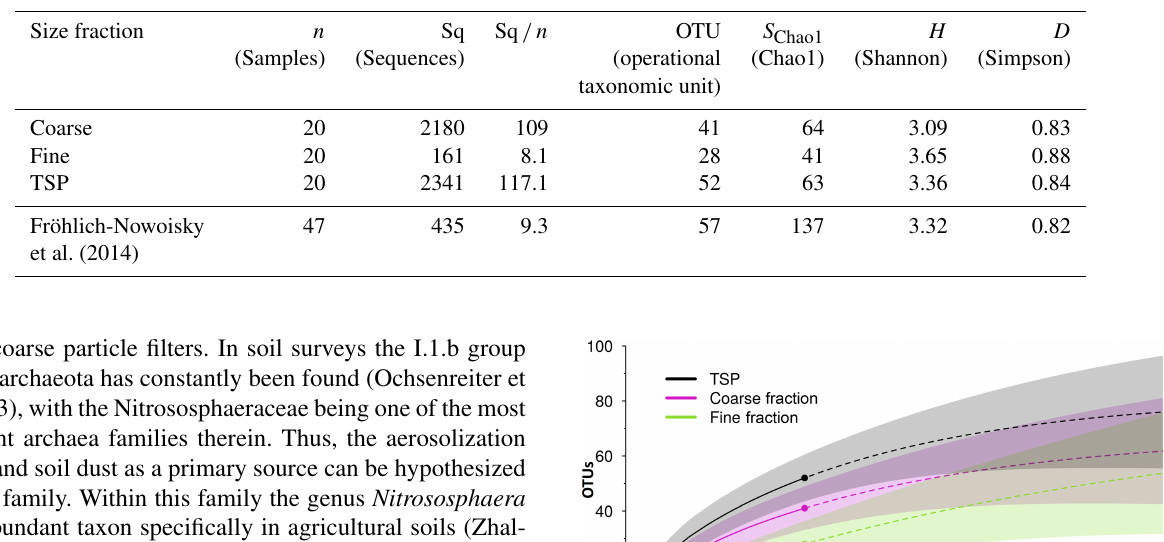
Table 1. Number of sequences and indices estimating the archaeal diversity in Mainz for coarse and fine particle filter samples and total suspended particles (TSPs).